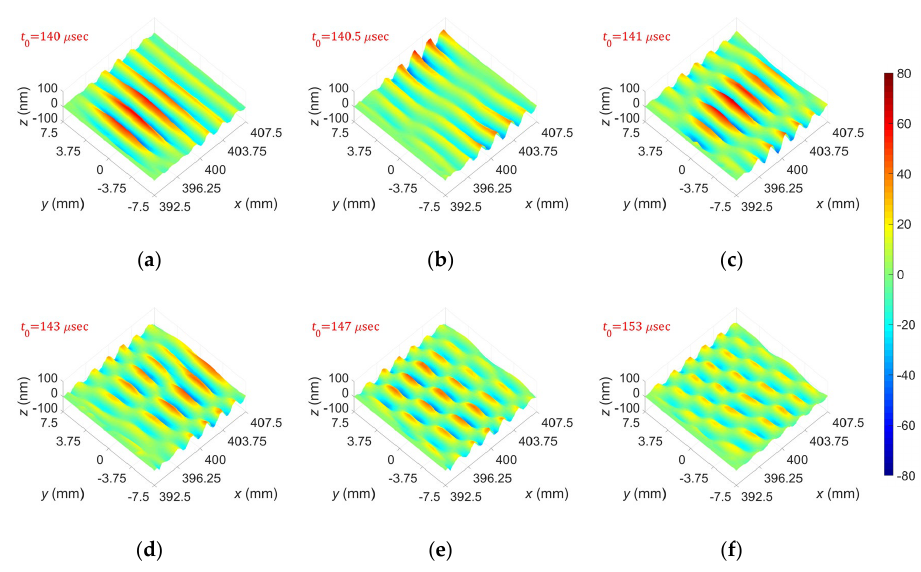
Figure 15. Experimentally obtained out-of-plane displacement distributions for ( a ) A(0,0), ( b ) A(0,1), ( c ) A(0,2), ( d ) A(0,3), ( e ) A(0,4), and ( f ) A(0,5) modes.